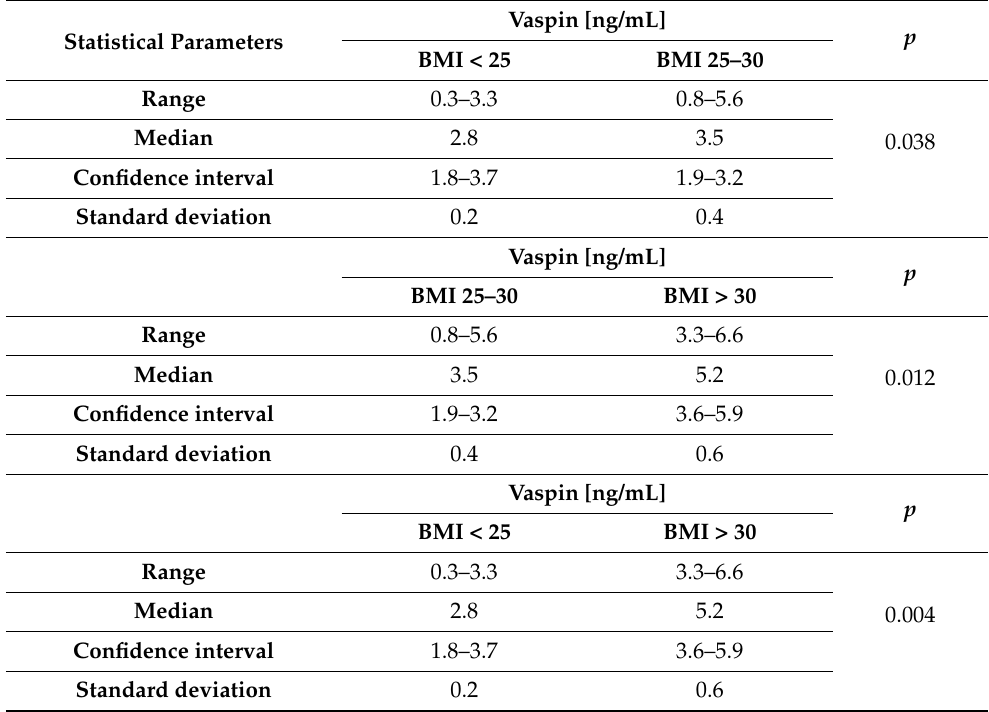
Table 4. Based on the evaluation of serum vaspin levels in relation to subgroups division: BMI, body mass